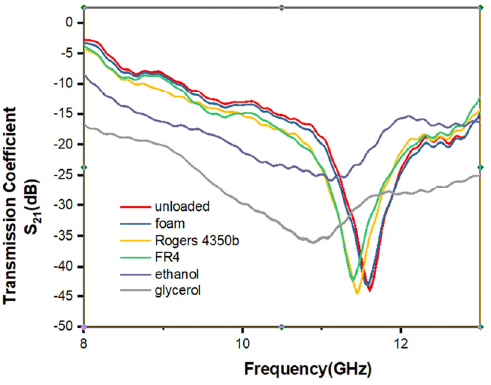
Figure 13. Measurement results when sensor is loaded with MUT with different dielectric properties.